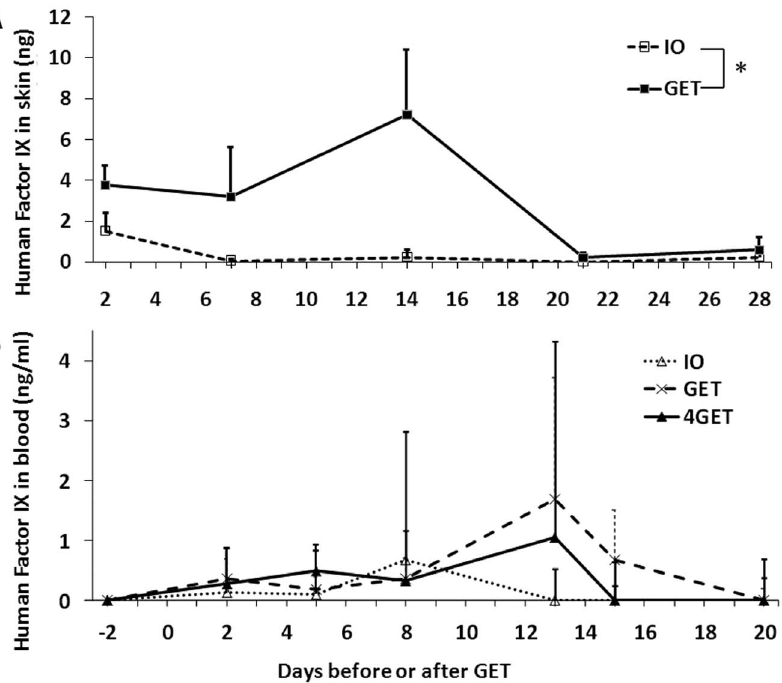
Figure 5. Human factor IX protein in HLGP after i.d. DNA (pNGVL3/CMVi/hFIXm1) injection and non-invasive GET. A , Human factor IX in HLGP skin. Delivery groups, IO: 50 m L DNA without pulse delivery; GET: 50 m L DNA with 1 pulse delivery on the injection site. Bars represent mean 6 SD. 3 sites were analyzed for each delivery. * p , 0.05 by Student’s t-test. B , Human factor IX in HLGP plasma. Delivery groups, IO: 50 m L DNA without pulse delivery; GET: 50 m L DNA with 1 pulse delivery on the injection site. 4GET: 4 6 50 m L DNA with 4 pulse delivery on the injection site. Bars represent mean 6 SD. 4 HLGPs were analyzed for each delivery group.